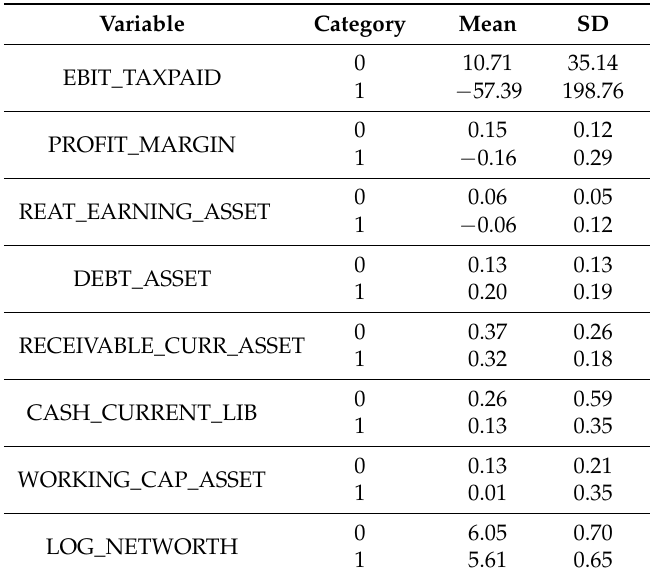
Table 1. Descriptive Statistics—Training